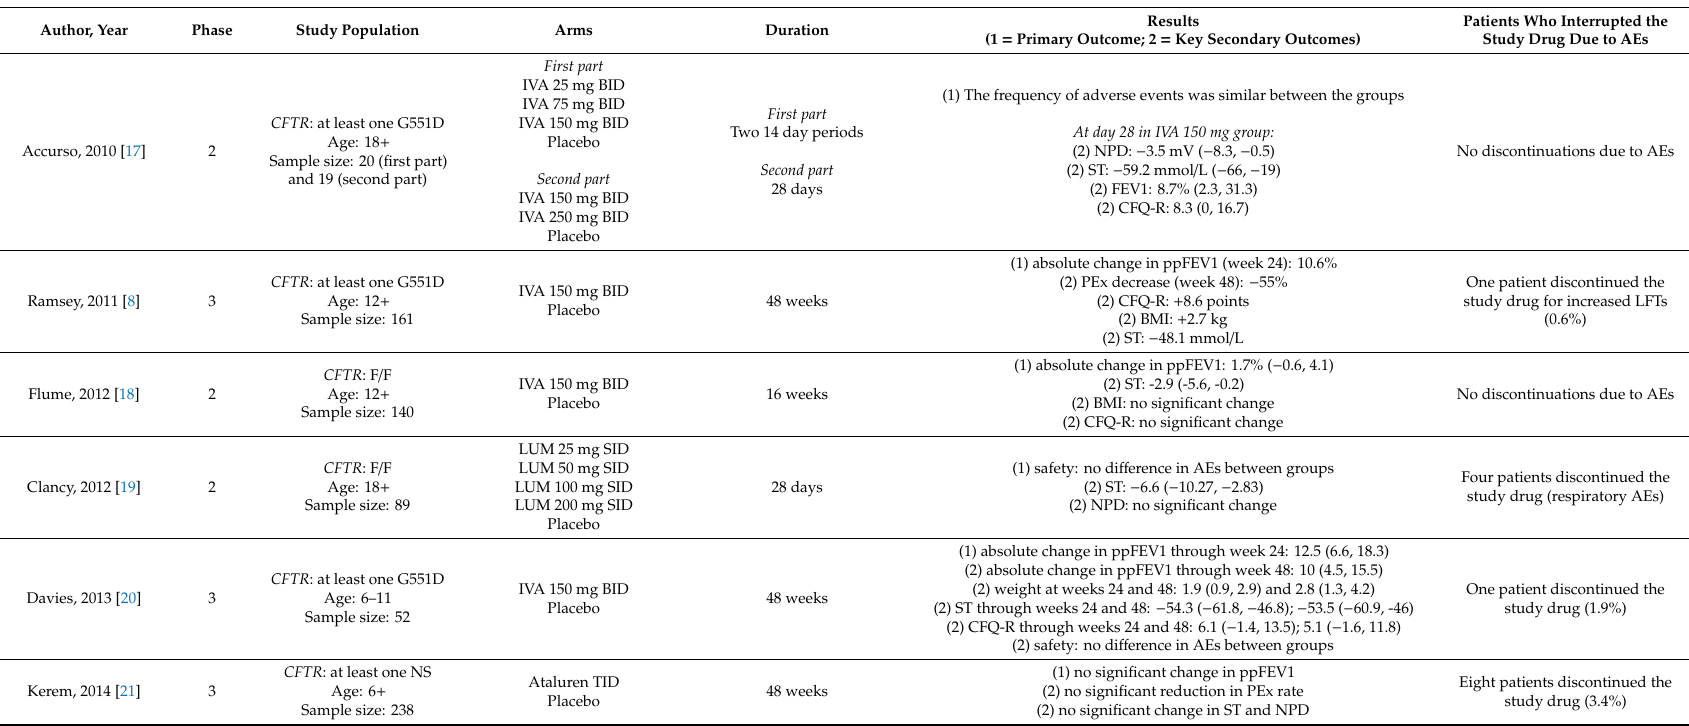
Table 1. Results of the systematic